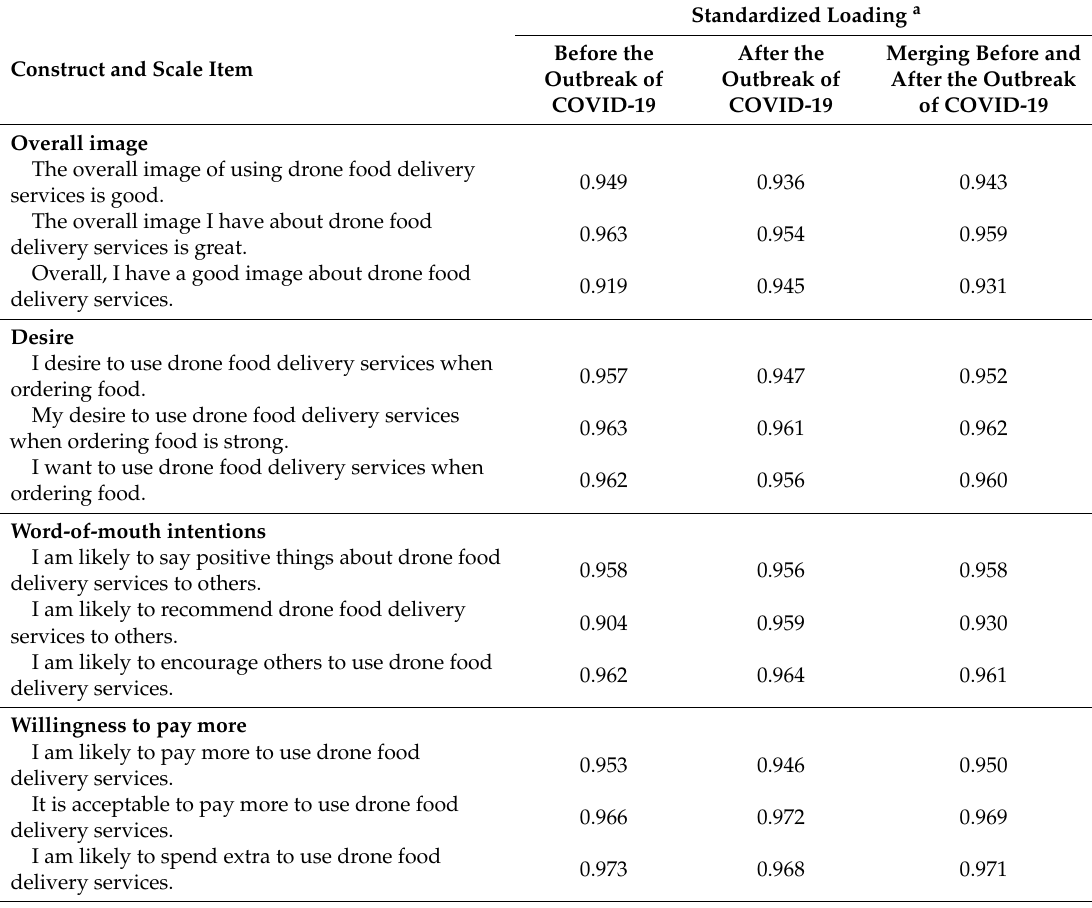
Table 2. The confirmatory factor analysis: Items and